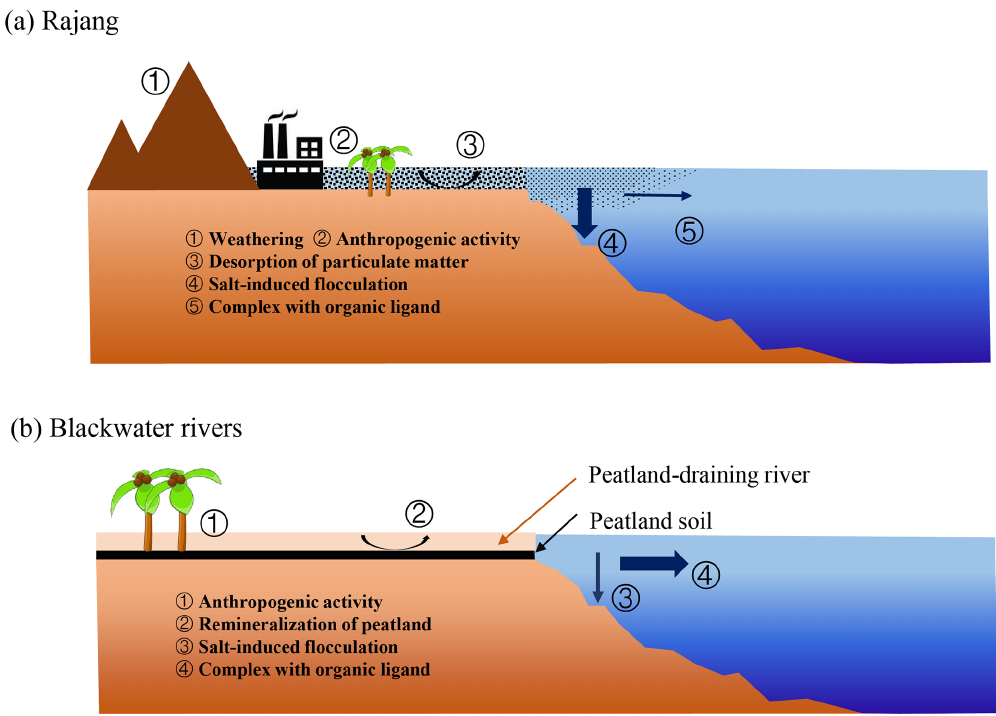
Figure 5. Schematic representation of the dFe biogeochemical behaviors in the Rajang River (a) and blackwater rivers (b) . It highlights the anthropogenic influences on the dFe concentrations in the tropical